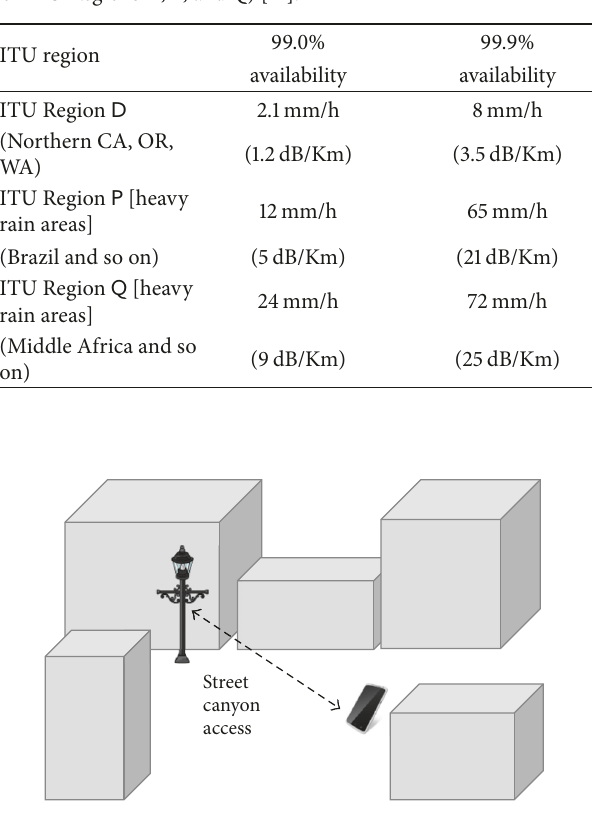
Figure 4: Illustration of street canyon access [11].